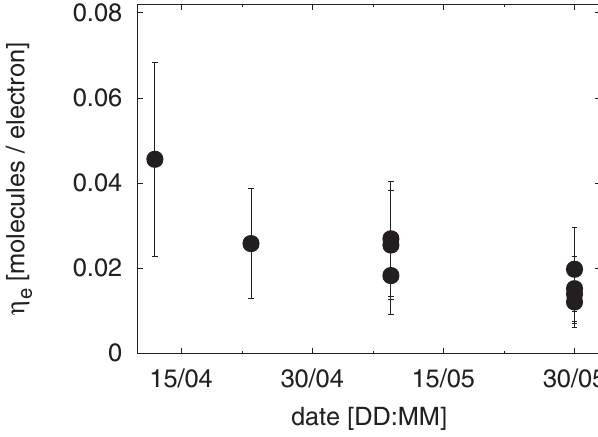
FIG. 8. Summary of all calculated desorption coefficients for the unbaked surface BO2. The error bar (50%) stems from the uncertainty in the pumping speed and vacuum pressure readings. A slight decrease of the desorption coefficient with time is noticeable due to the scrubbing effect.